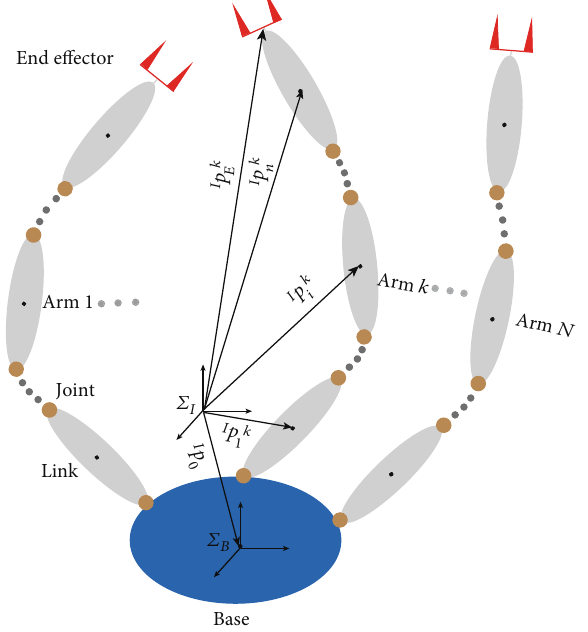
Figure 1: The model of a dual-arm space robot, which has two arms, and each arm has n k